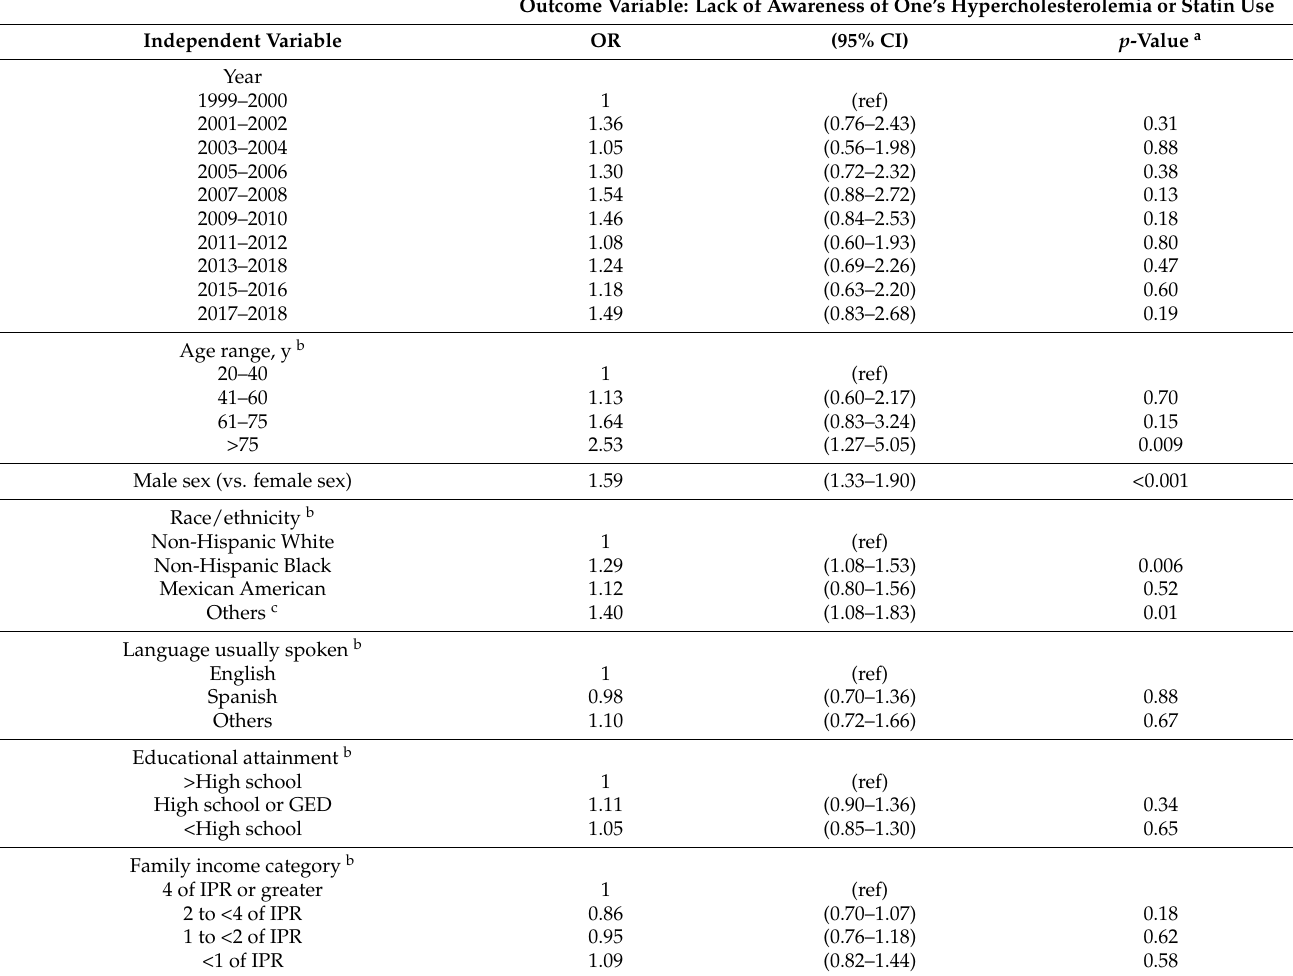
Table 3. Odds ratios for lack of awareness of one’s hypercholesterolemia status or statin use. Outcome Variable: Lack of Awareness of One’s Hypercholesterolemia or Statin